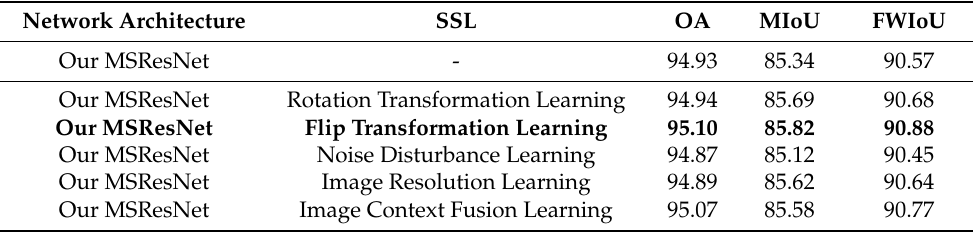
Table 1. Quantification of the effectiveness of our MSResNet via five SSL strategies on the 2020 Gaofen Challenge water-body segmentation dataset (%).